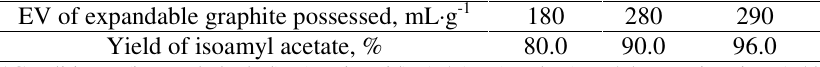
Figure 3 . Influence of alcohol/acid mole ratio on esterification conversion (Condition ： dosage of expandable graphite (EV=290 mL·g -1 ) equal 7.5% ， ） reaction time 1.5 h Table 3. Influence of EV of expandable graphite on esterification* EV of expandable graphite possessed, mL·g -1